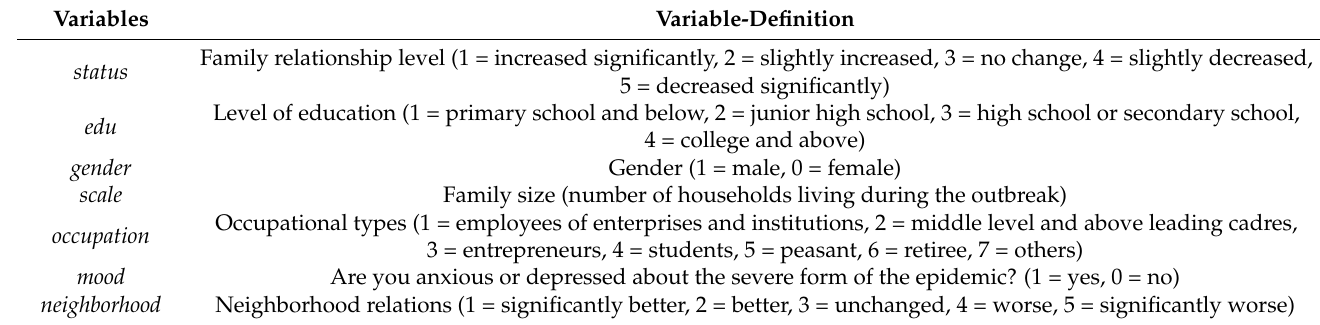
Table 1. Variable setting and meaning in the